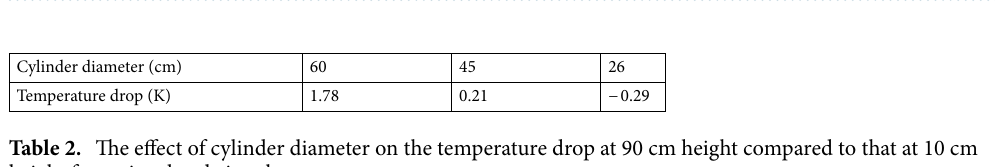
Figure 4. The effect of cylinder diameter on the temperature drops at 90 cm height along the centerline compared to the temperature at 10 cm height for an insulated air column, measured for 30 days from June 18th, 2021, in Gyeongju, Korea.